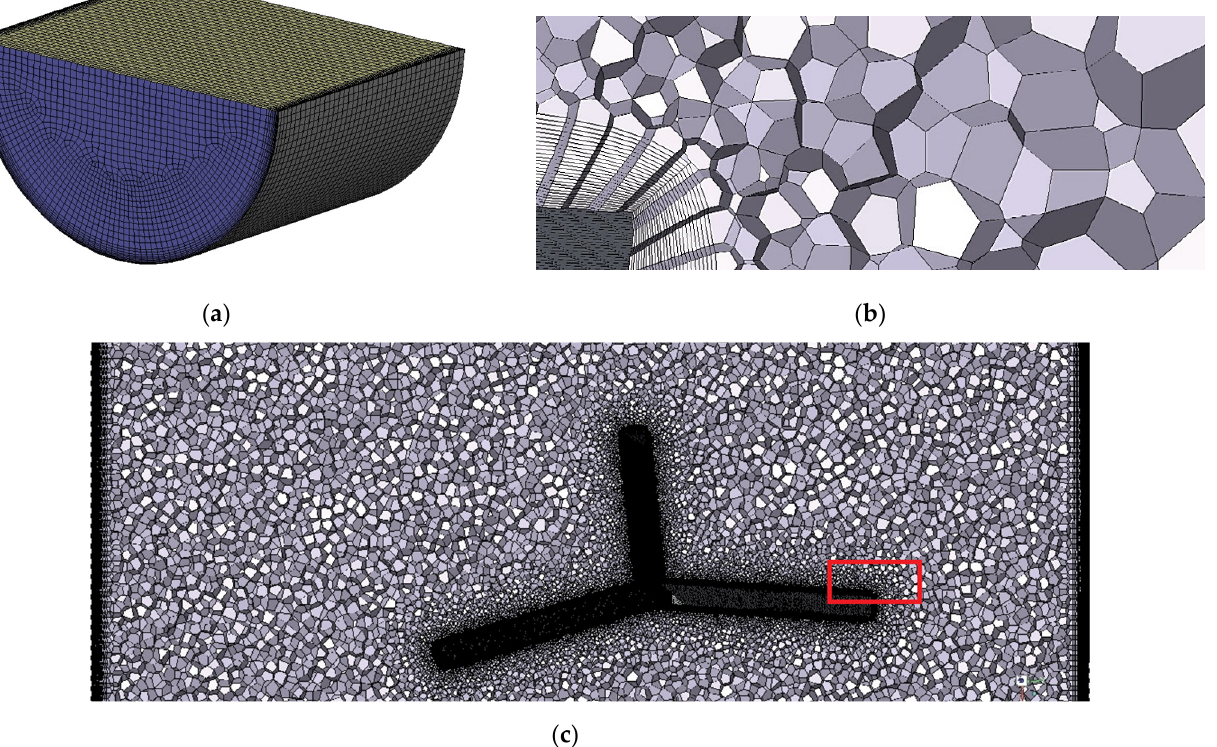
Figure 10. Three-dimensional mesh. ( a ) Inlet of the domain; ( b ) boundary layers on the oscillator’s surface; ( c ) the proximity of the oscillator, view of cross-section below the support. Zoomed area marked in red.